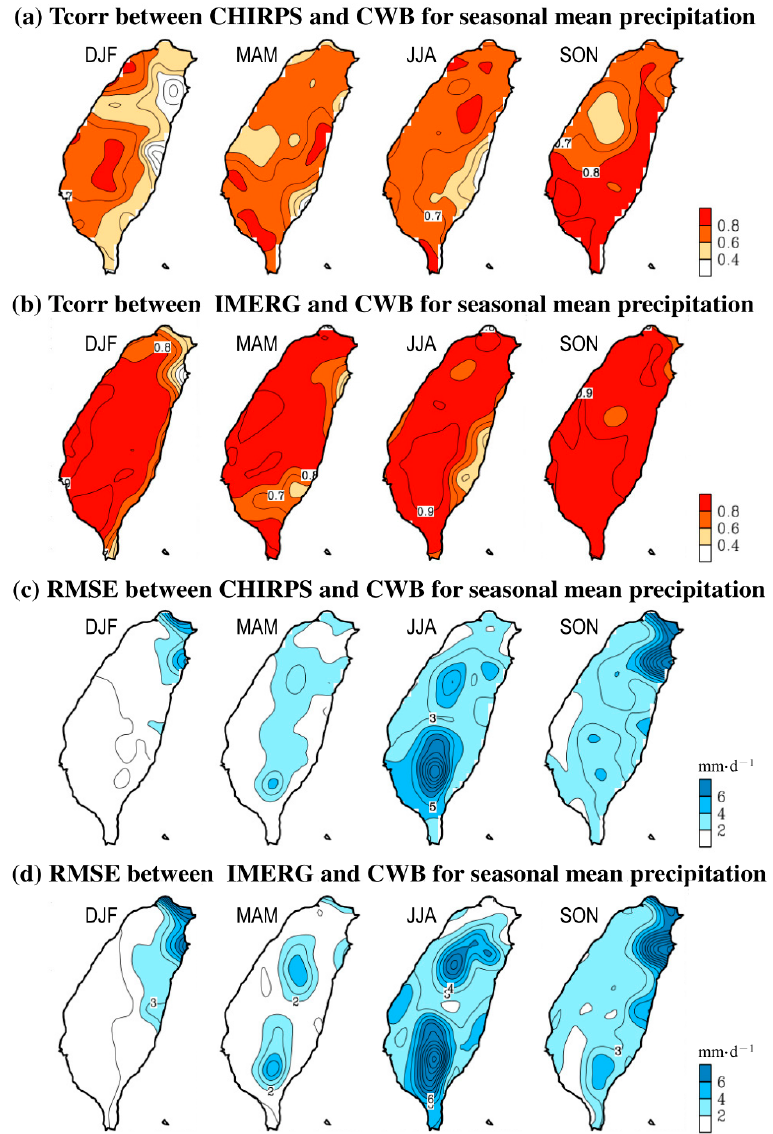
Figure 5. Grid-to-grid temporal correlation (Tcorr) between seasonal mean precipitation during 2001–2019 for winter (DJF), spring (MAM), summer (JJA), and autumn (SON) estimated by CWB and two SPPs: ( a ) CHIRPS and ( b ) IMERG. ( c , d ) are determined using the same time series as that used for ( a , b ), respectively, but calculated for RMSE between CWB and two SPPs for the four seasons.